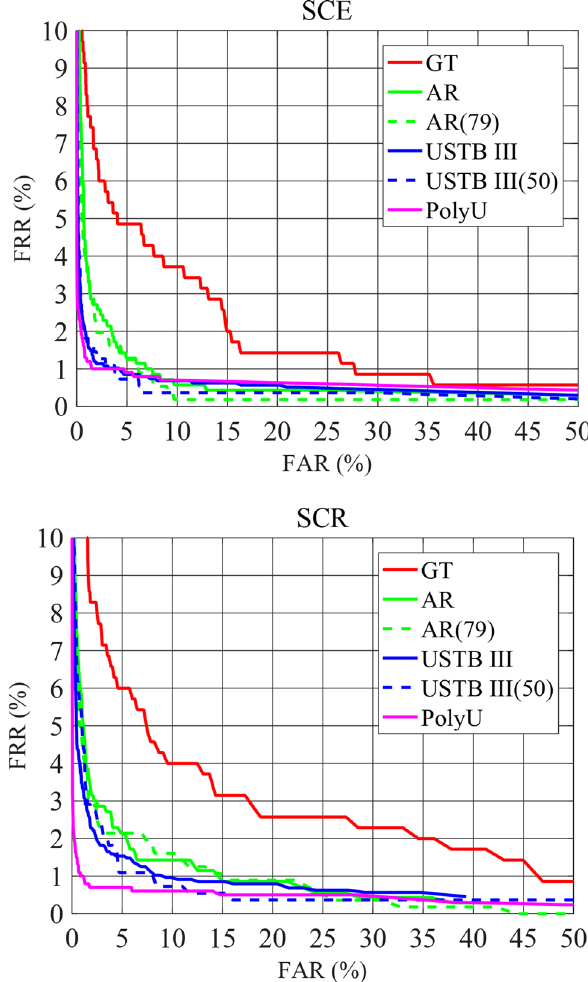
Fig. 6 The ROC curves of SRC-based unimodal verification with SCE and SCR when using DCT features